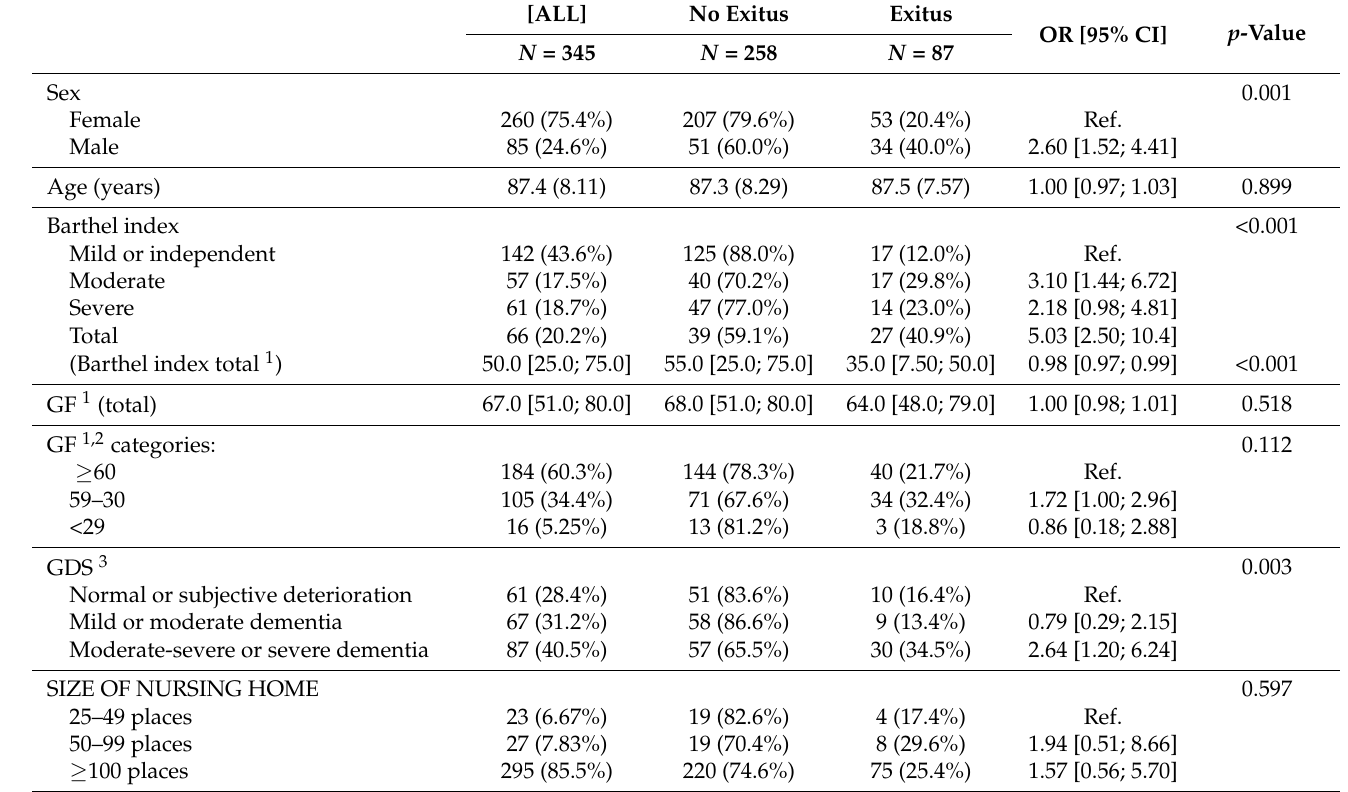
Table 3. Factors related to mortality by SARS-CoV-2.